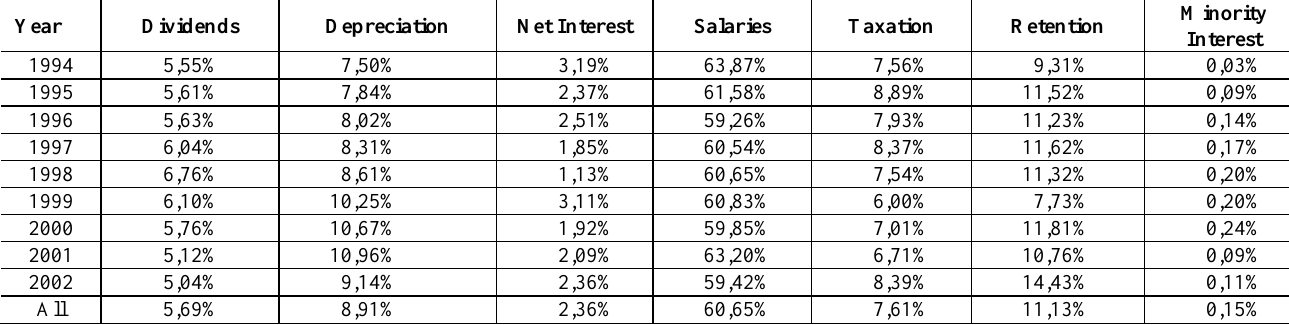
Table 9: Median values of distribution ratios – constant sample 1994 to